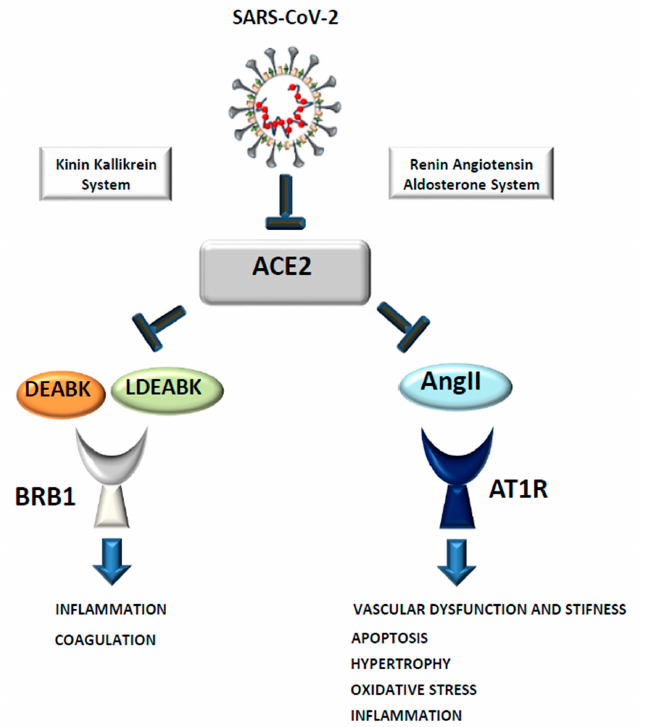
Figure 5. SARS-CoV-2 dependent ACE2 internalization as a possible cause of the cytokine storm. The binding of SARS-CoV-2 to ACE2 can cause its internalization and a decreased level on the plasma membrane. This leads to an increase in AngII and DEABK/LDEABK causing vasoconstriction, apoptosis, oxidative stress, and an overproduction of proinflammatory cytokines through their receptor AT1R and